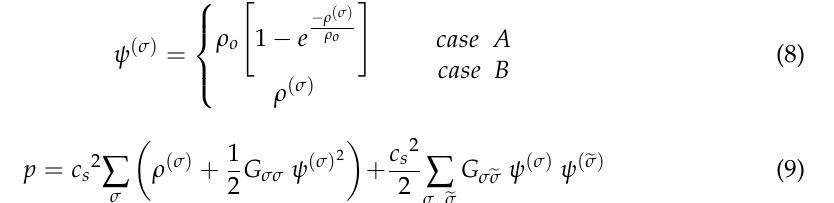
Table 1. Weighting parameter